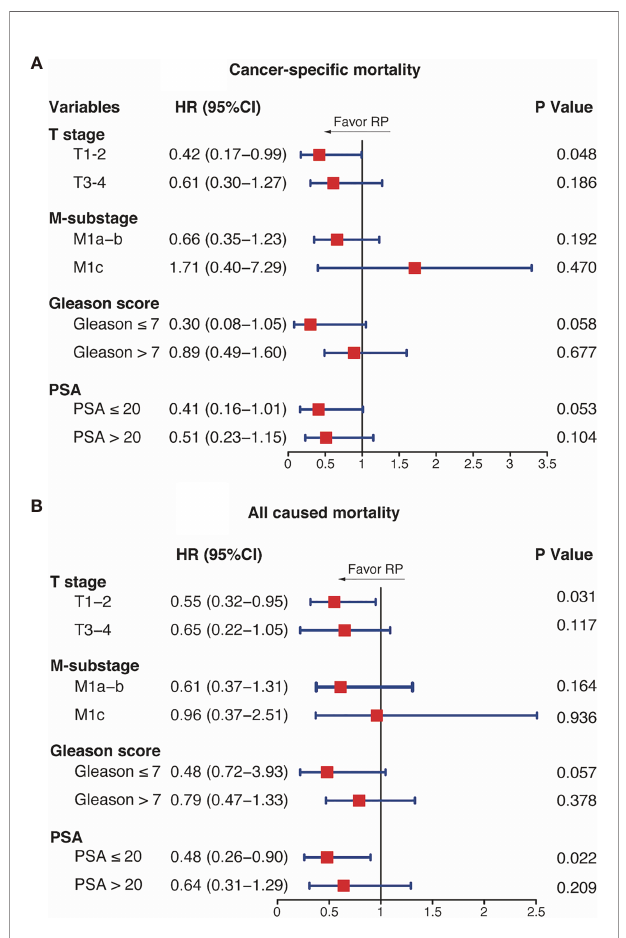
FIGURE 4 | Subgroup analysis of cancer-speci fi c mortality (A) and all-cause mortality (B) with brachytherapy (RT) and radical prostatectomy (RP). HR , hazard ratio; CI , con fi dence intervals; PSA , prostate-speci fi c antigen; GS , Gleason